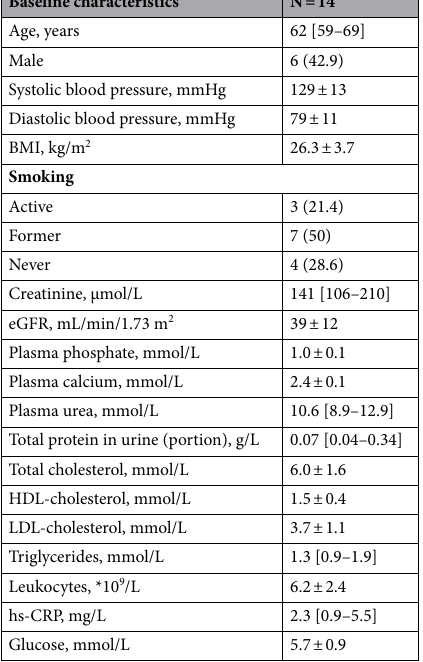
Table 1. Baseline characteristics.